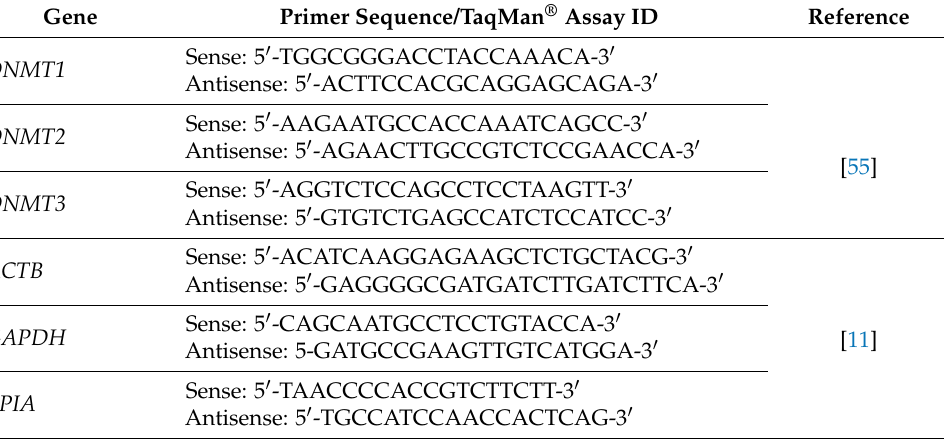
Table 2. Primer sequences and TaqMan ® assays used in real-time RT-PCR analyses.